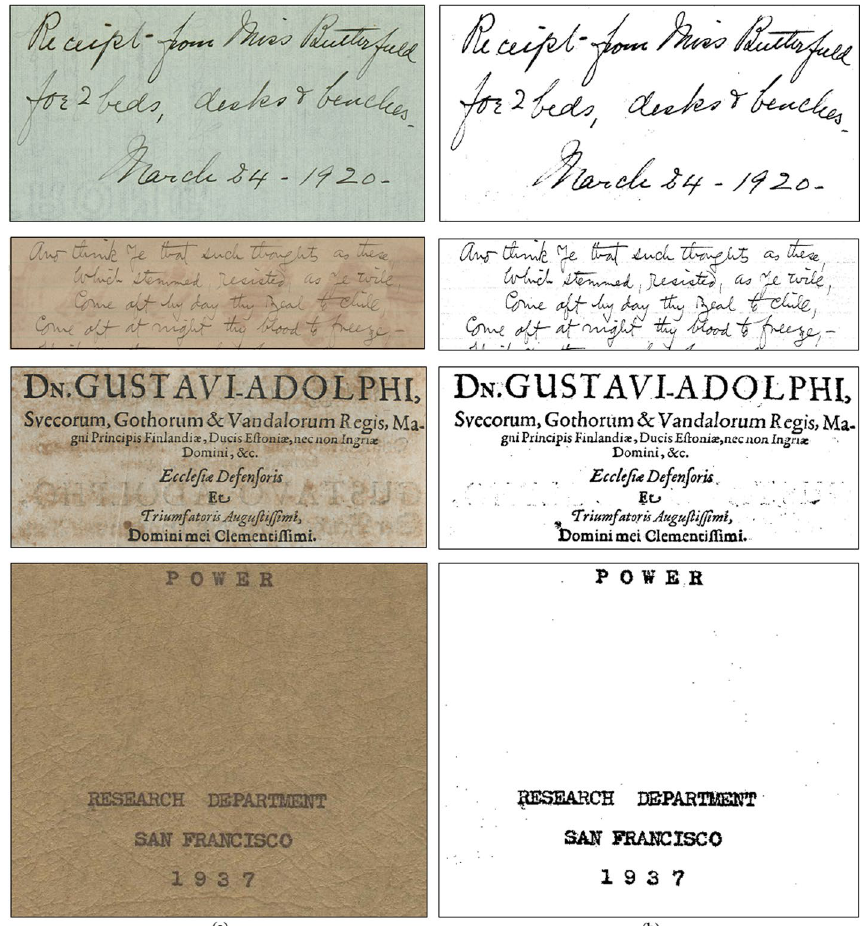
Fig. 3 Images binarization results from DIBCO 2011: a Original degraded images, b recovered text by the proposed non-local